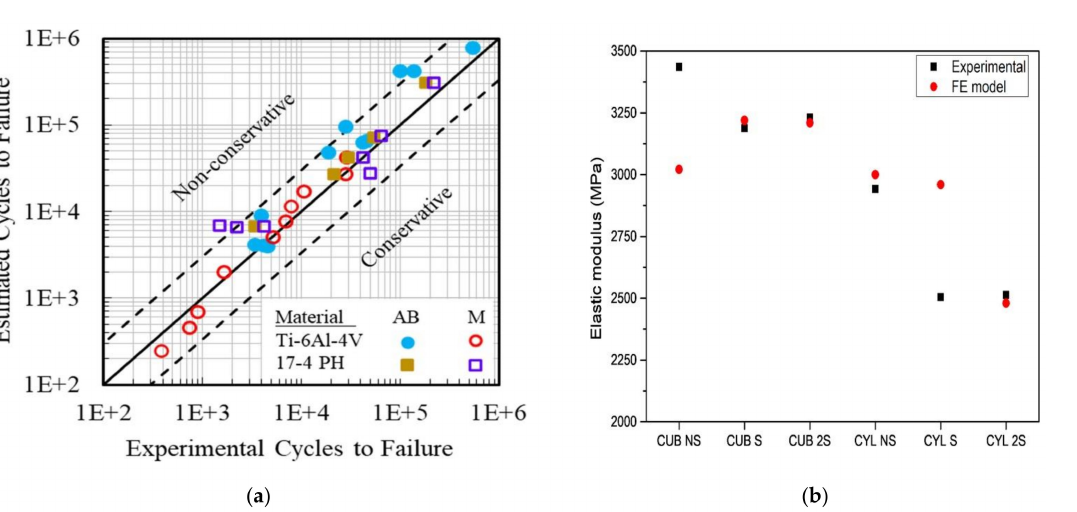
Figure 29. ( a ) notched axial, torsion, in-phase, and 90 ◦ out-of-phase fatigue test lives vs. FASTRAN life estimation results for LPBF Ti-6Al-4V and 17-4PH alloys with as-built (AB), machined (M) surface conditions. Dashed lines indicate factors 1/3 and 3 scatter bands [75], ( b ) Comparison of the elastic modulus as calculated from the FE analyses based on the CAD model and the experimental values. Reprinted with permission from ref. [79]. 2020, John